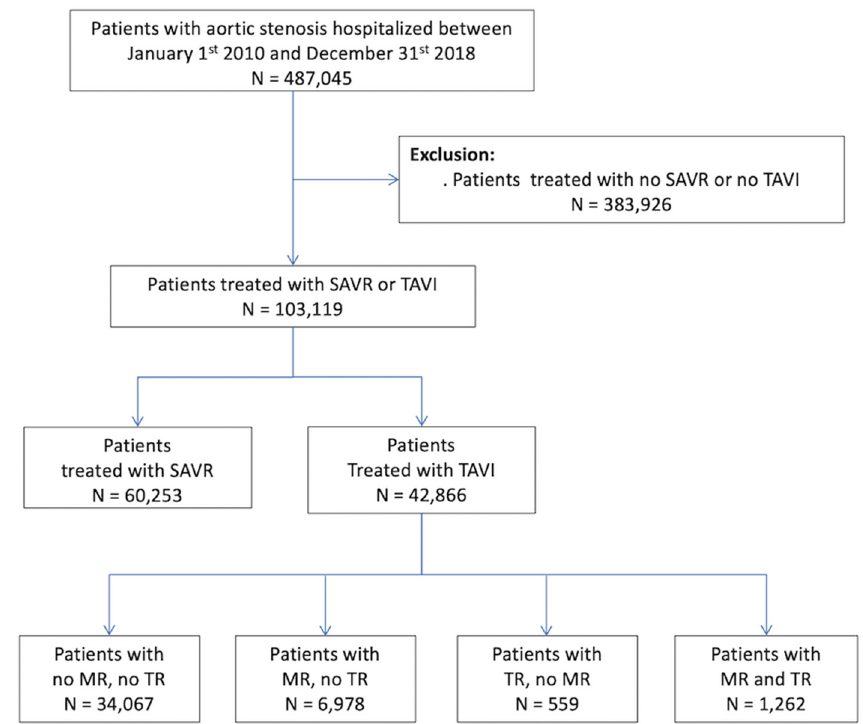
Figure 1. Flow chart of the study patients. MR: mitral regurgitation; SAVR: surgical aortic valve replacement; TAVI: transcatheter aortic valve implantation; TR: tricuspid regurgitation. During the follow-up, the yearly incident all-cause mortality rate was 16.89% (95%CI 16.07–17.75) in TAVI recipients with concomitant MR, as compared to 14.39% (95%CI 14.02–14.78) in those without MR (HR: 1.192, 95%CI: 1.125–1.263) (Table S2) Likewise, the yearly incidence and risks of cardiovascular mortality and rehospitalization for heart fail- ure were significantly higher in TAVI patients with MR than those without. No difference was observed in the incidence and risk of stroke between the two groups (Table S2). Cu- mulative incidences curves with higher risk for all-cause mortality and cardiovascular mortality for TAVI patient with MR compared to those with no baseline MR at baseline are presented in Figure 2. Cumulative incidences curves for ischemic stroke and rehospi- talization for HF for TAVI patient with MR compared to those with no baseline MR at baseline are presented in Figure S1.